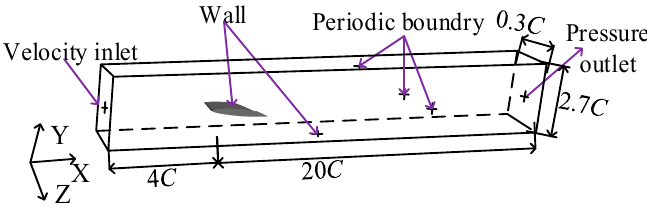
Figure 1. Computational domain and boundary condition .